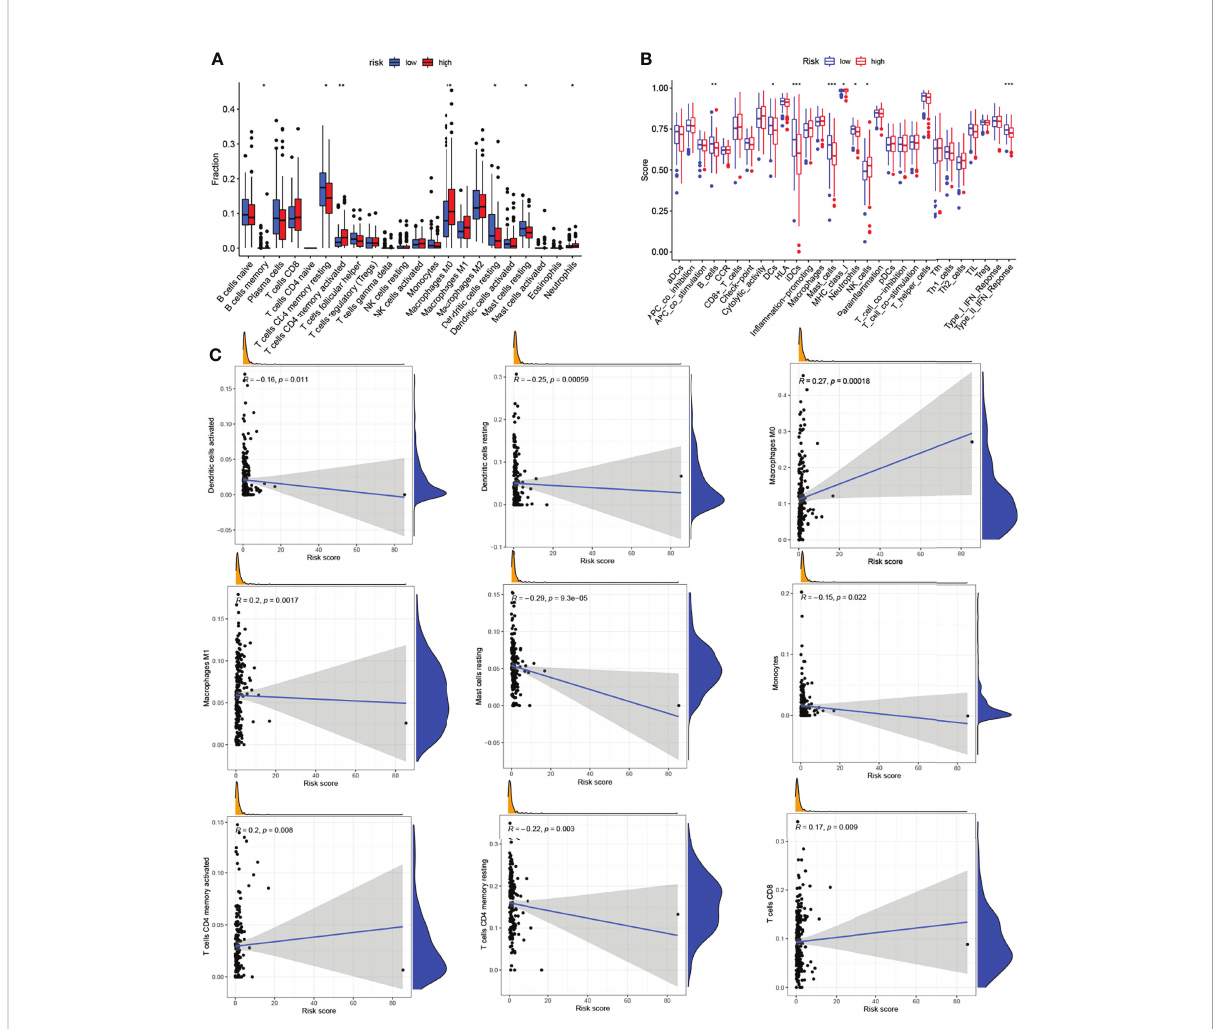
FIGURE 6 Analysis of the immune activity in different groups. (A) Comparison of various types of immune cells. (B) Comparison of various immune- correlated pathways. (C) Relationship between the in fi ltration of immune cells and the risk model. * p < 0.05; ** p < 0.01; *** p <